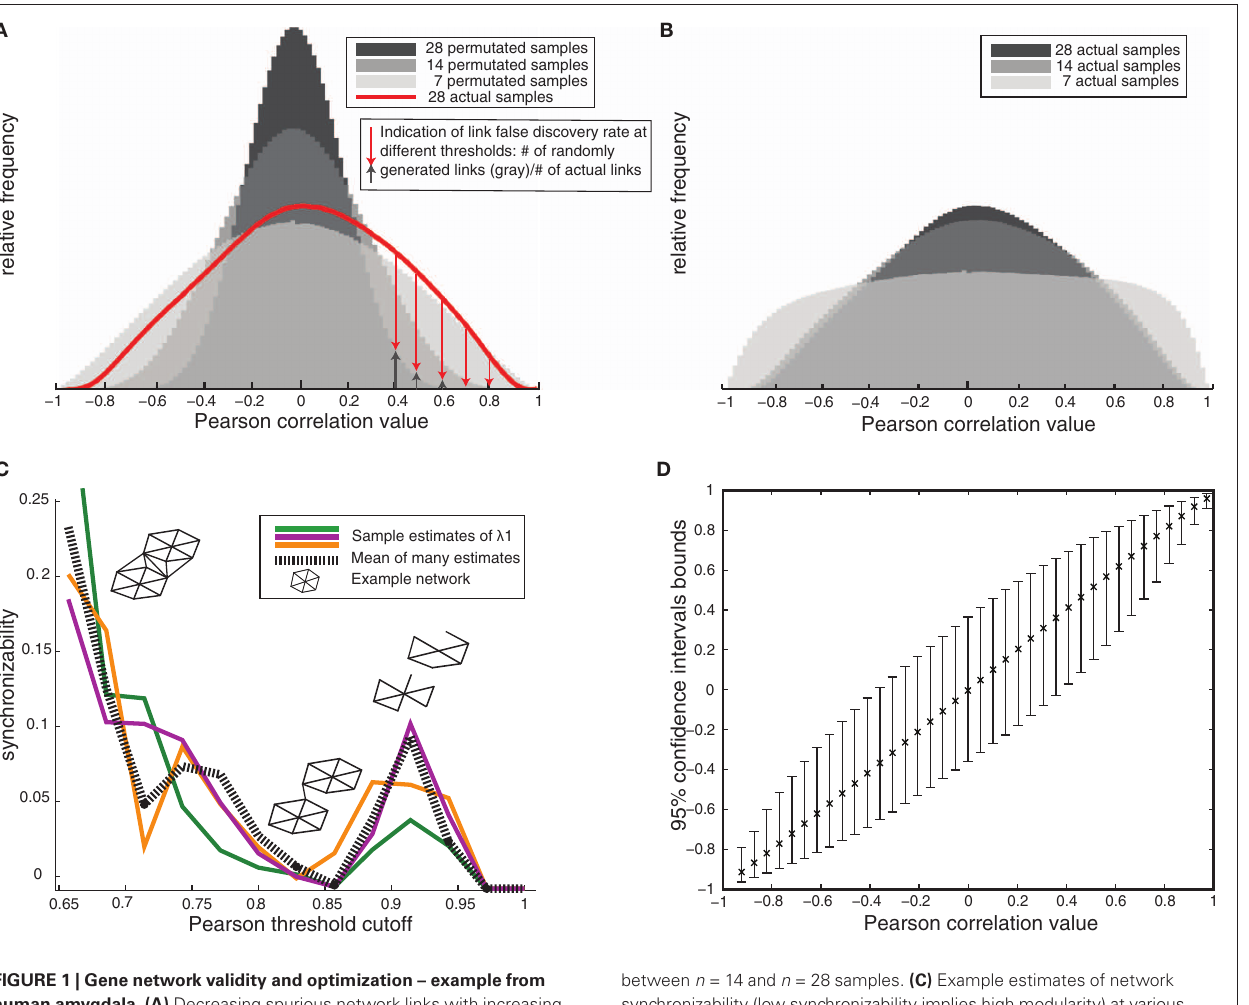
Figure 1 | gene network validity and optimization – example from human amygdala. (A) Decreasing spurious network links with increasing sample size is shown by the null correlation distributions in permutated samples decreasing toward zero with increasing sample size, and the greater number of high correlations in real versus permutated data (red). (B) Decreasing false-positive correlations in the actual data set with increasing sample size is shown as a decrease in the number of extreme correlations when comparing 7–14 samples. Correlation values then remains constant